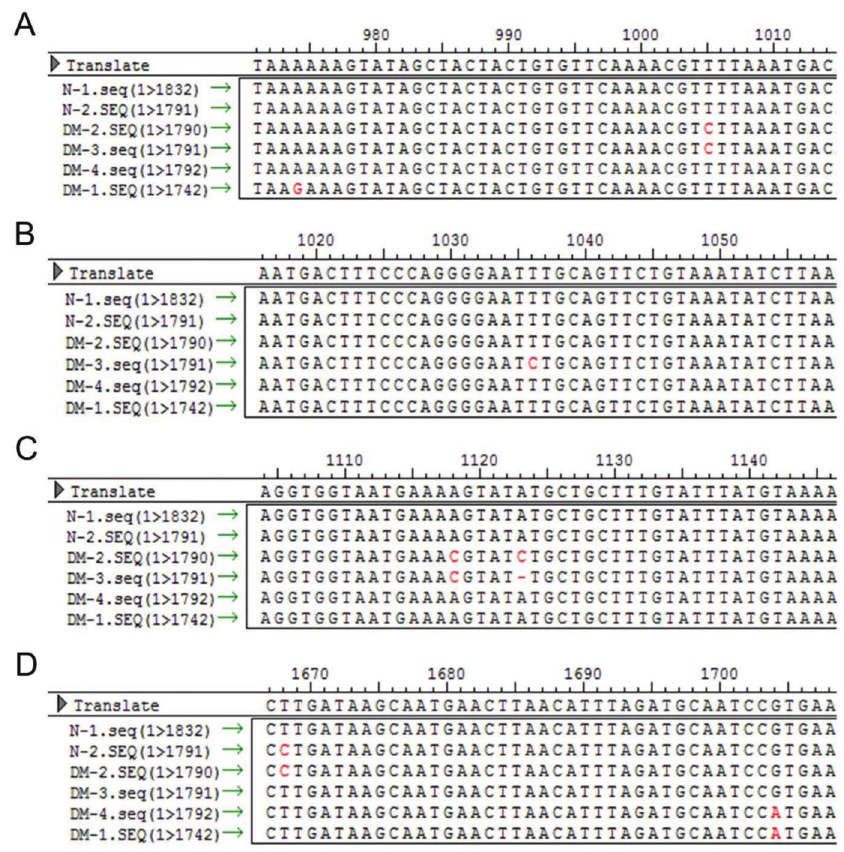
Figure S5 - miRNA-binding SNP locus mutation analyses in the 3 0 -UTR of DRD1 in the ED group. A Analyses of miRNA-binding SNPs in other regions of the 3 0 -UTR of DRD1 in healthy donors (N-1, N-2) and ED groups with essential hypertension and type 2 diabetes mellitus (DM-1, DM-2, DM-3, DM-4), such as 971-1014 ( A ), 1016-1058 ( B ), 1104-1146, ( C ) and 1667-1708 ( D ).